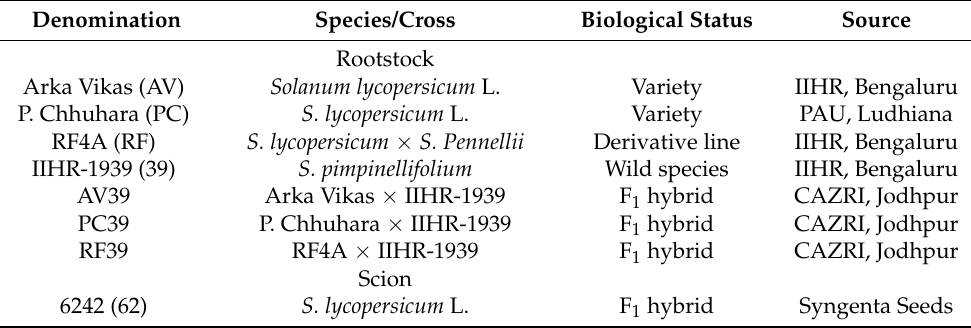
Table 1. List of genotypes and species used as rootstock and scion in the study. Denomination Species/Cross Biological Status Source Rootstock Arka Vikas (AV) Solanum lycopersicum L. Variety IIHR, Bengaluru